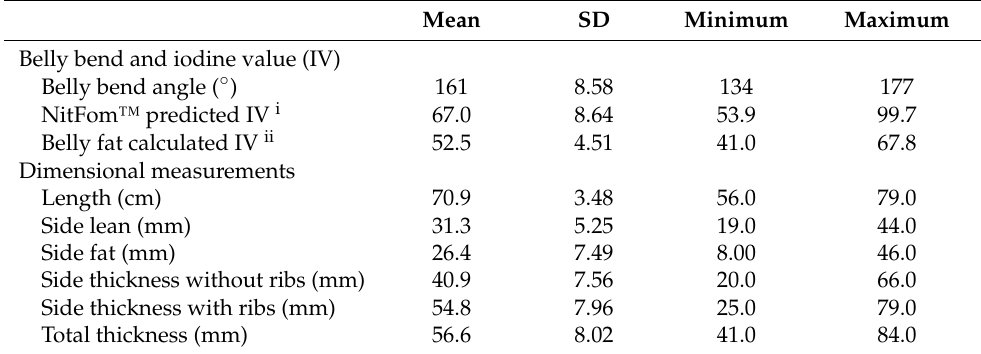
Table 1. Descriptive statistics of belly measurements.